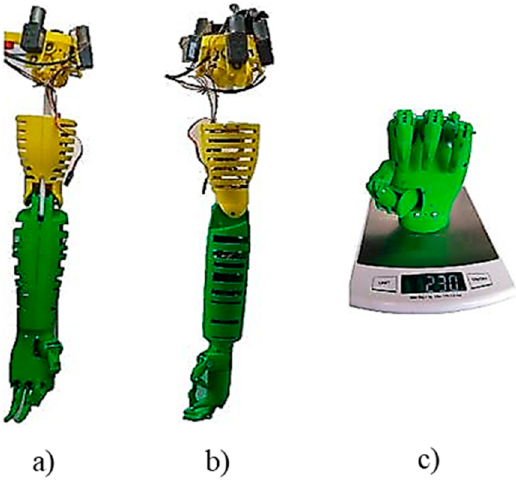
Figure 1. Arm of Leal-Naranjo. ( a ) Front view. ( b ) Side view. ( c ) Weight of the hand attached to the arm. Table 1. Materials to manufacture.